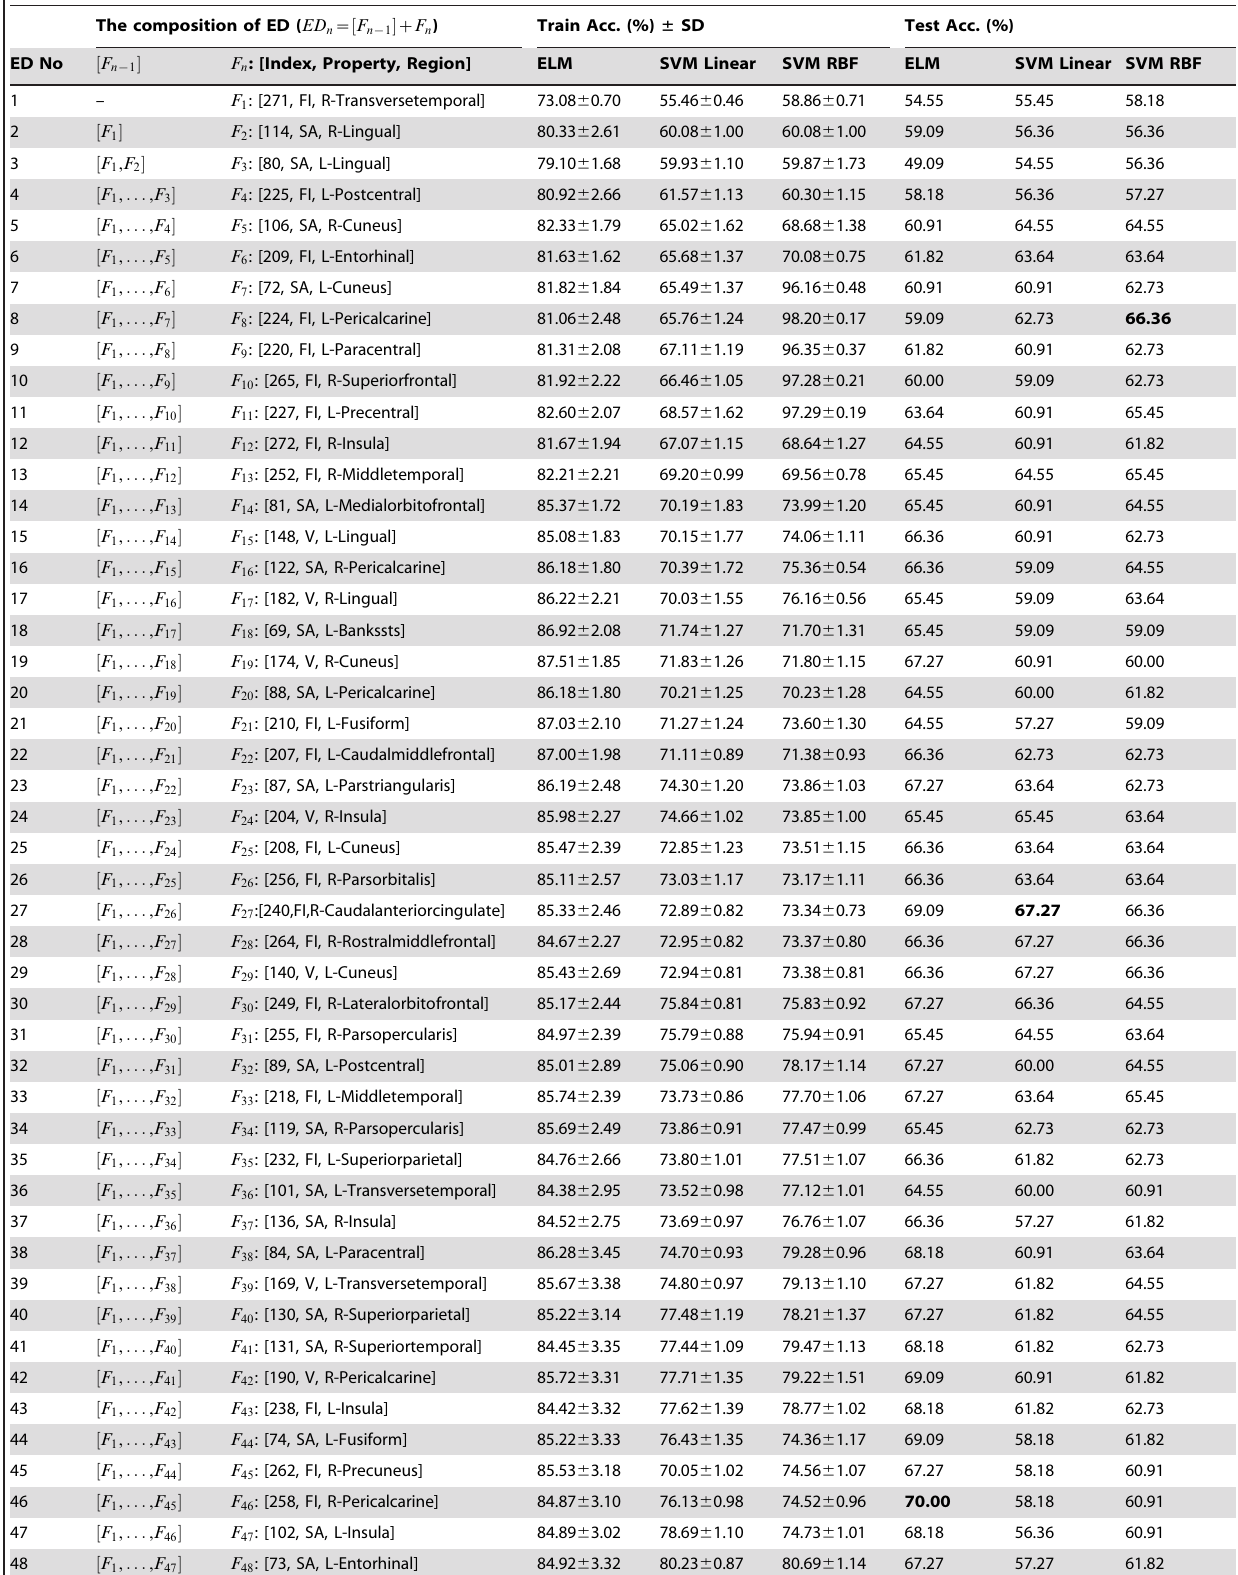
The composition of ED ( ED n ~ ½ F n { 1 (cid:2) z F n ) Train Acc. (%) ± SD Test Acc.